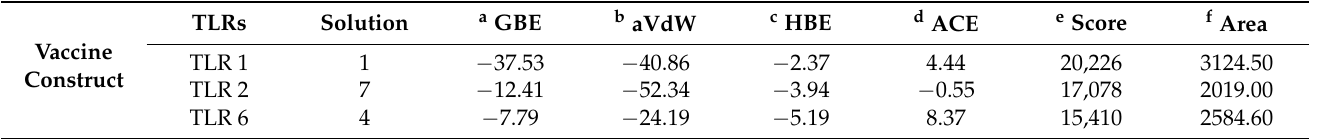
Figure 9. Molecular docking studies of the designed molecule with TLR 6. ( A ) Docked complex as predicted by ClusPro. The green ribbons depict the TLR 6 molecule, while the warm pink corresponds to the vaccine molecule. ( B ) HDOCK docked complex (yellow represents vaccine). ( C ) Residue interactions between TLR 6 and vaccine construct. Hydrogen bonds are indicated with blue lines. Table 5. Docking result produced by Patchdock and refined by